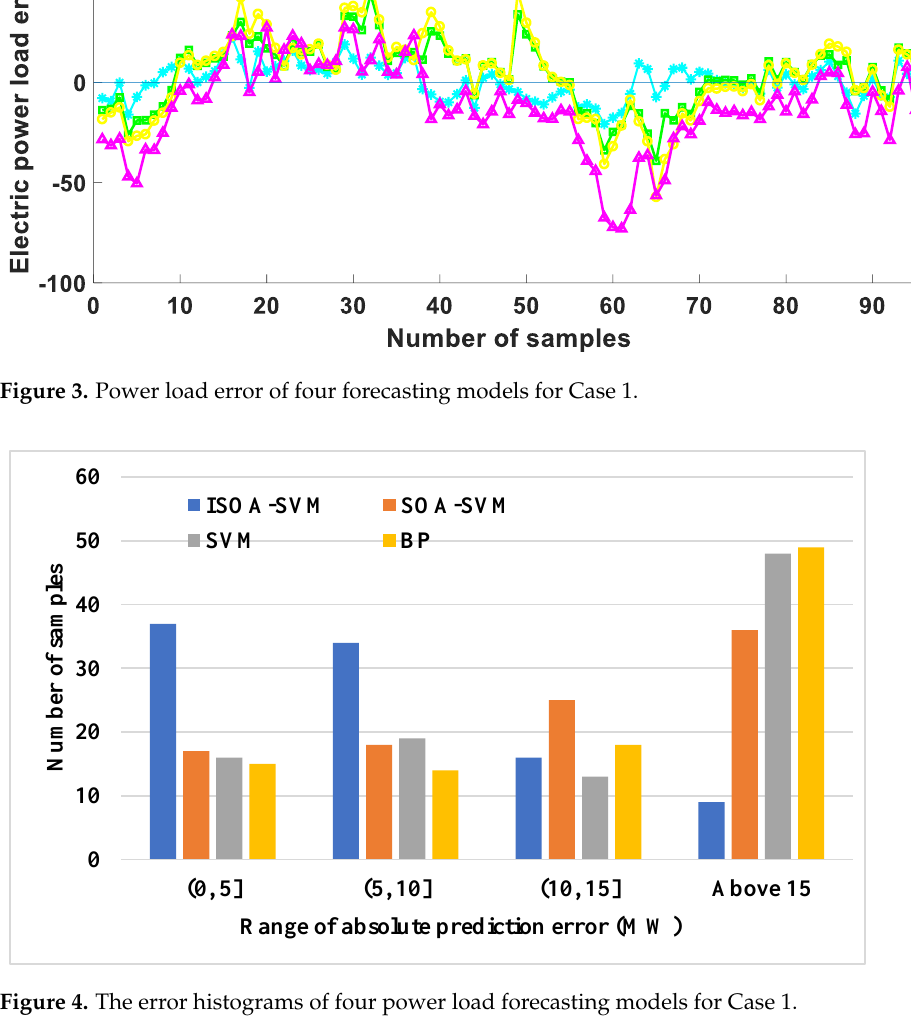
Figure 4. The error histograms of four power load forecasting models for Case 1.